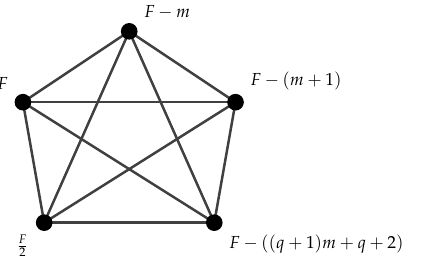
Figure 9. Minimum possible clique for the case m ≥ 2 q + 5, e = m − 2 q − 1 and q ≥